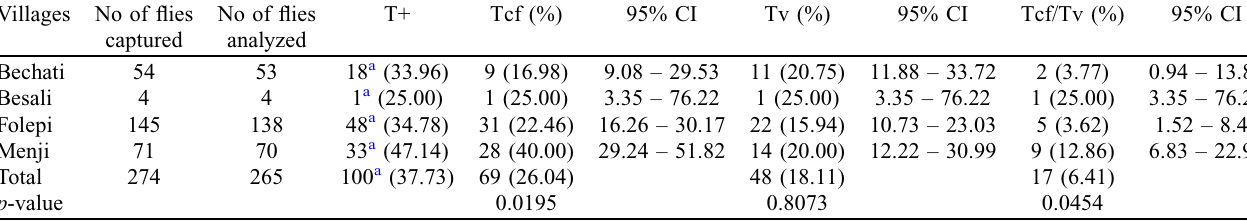
Table 3. Trypanosome infections according to villages. Villages No of flies